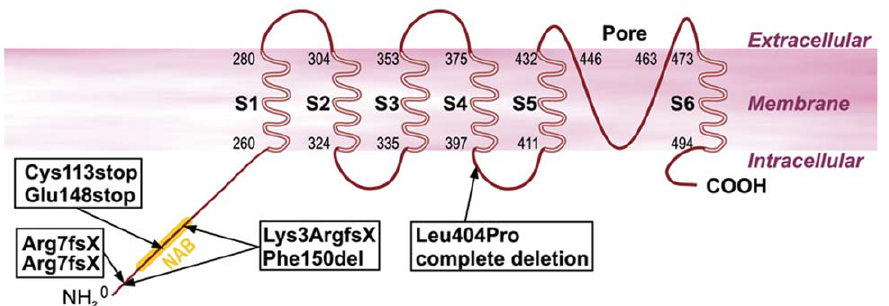
Figure 1. Structure of the Kv8.2 potassium channel and mutation sites detected in our patients. The mutation pairs in each box represent the genetic findings of each patient. The genetic findings of the two sibling pairs are shown once, since the siblings share the same mutation constellation.